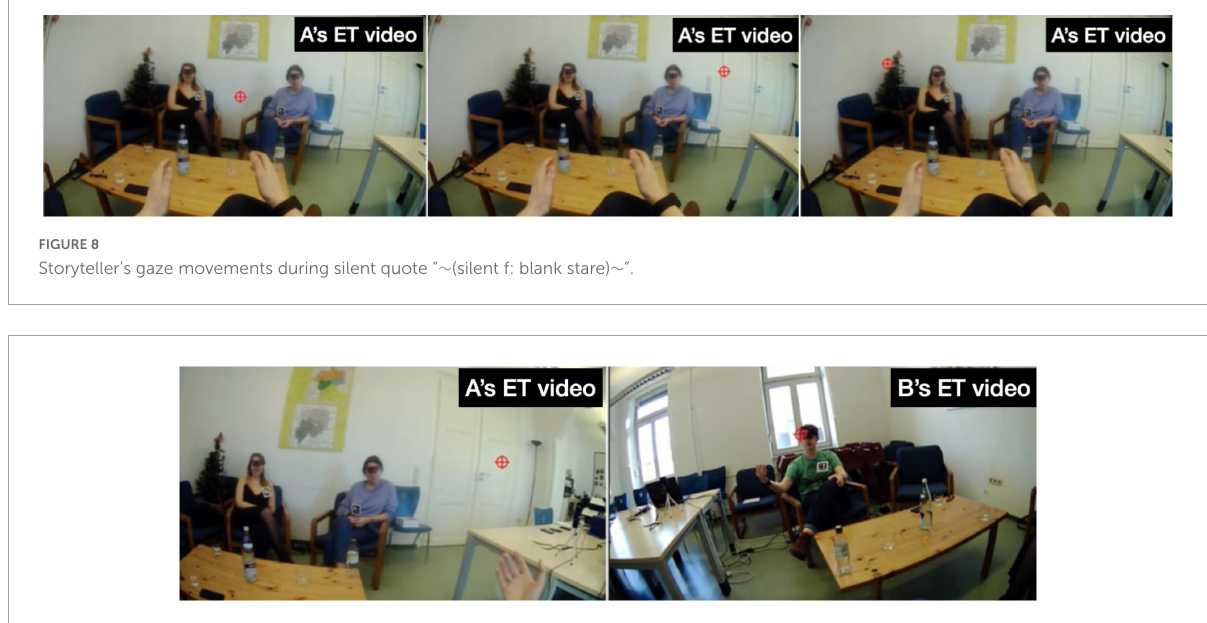
FIGURE9 Left panel: Storyteller’s gaze movement to the far right end during description of the second cleaning lady’s intervention “and the ↑ cleaning ↑ woman is there from the week be ↑ fore ↑ who had ↑ already ↑ done this=”; right panel: still from co-participant B’s eye-tracking video showing storyteller A’s open-palm gesture sweeping to the right in alignment with her right-sweeping